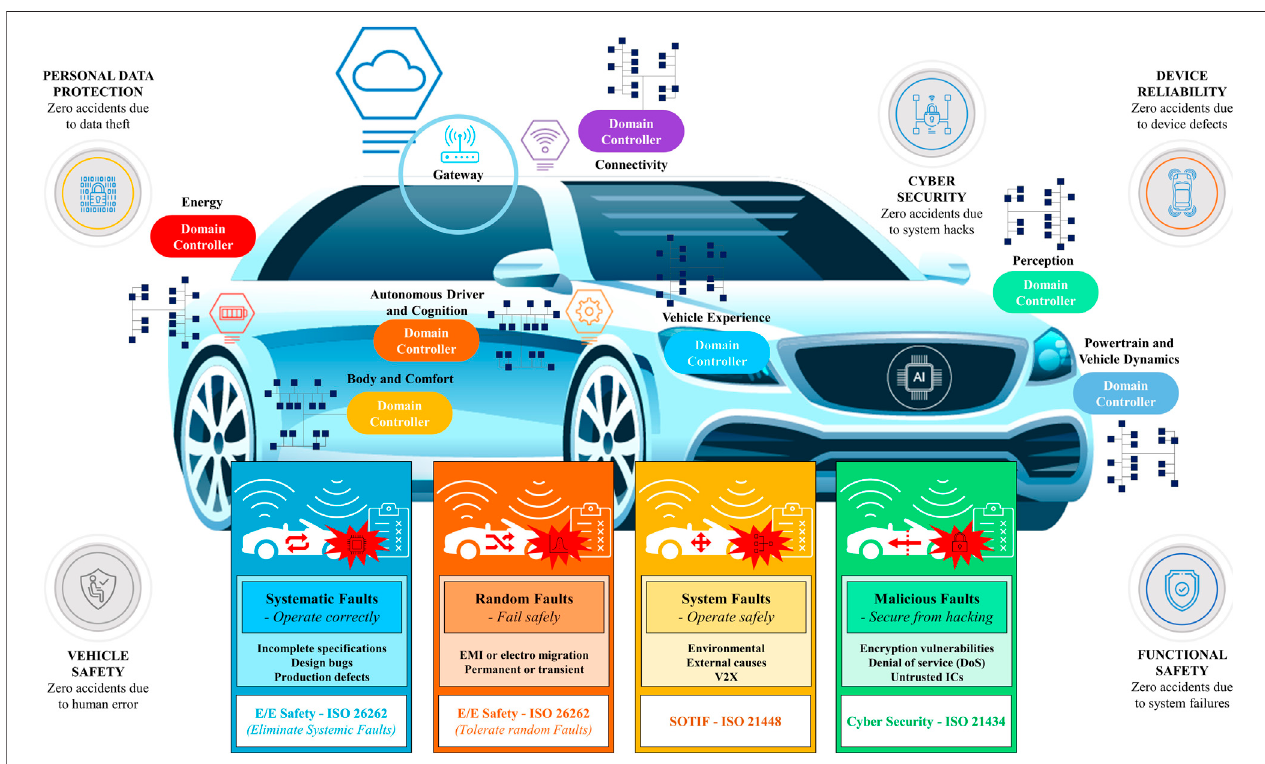
FIGURE 3 | Different failure types and faults in various